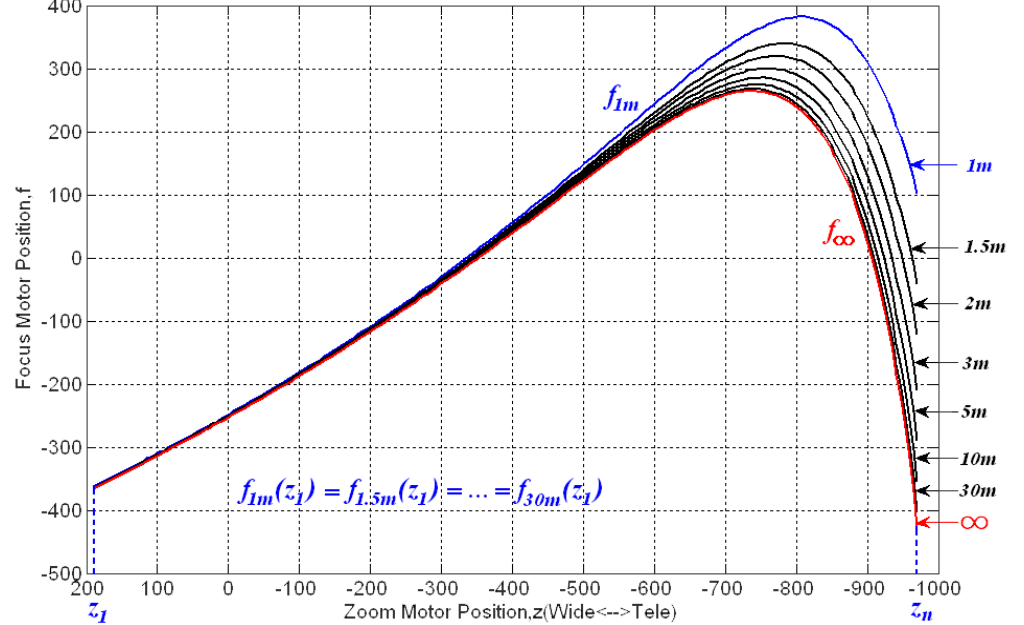
Figure 3. Trace curves for an 18 × zoom